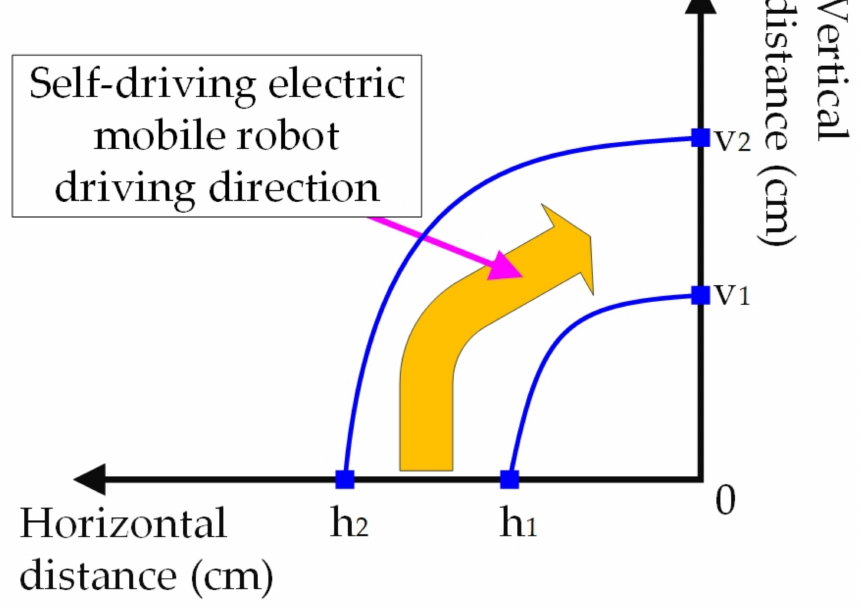
Figure 6. Curve diagram of the self-driving electric mobile robot taking a right